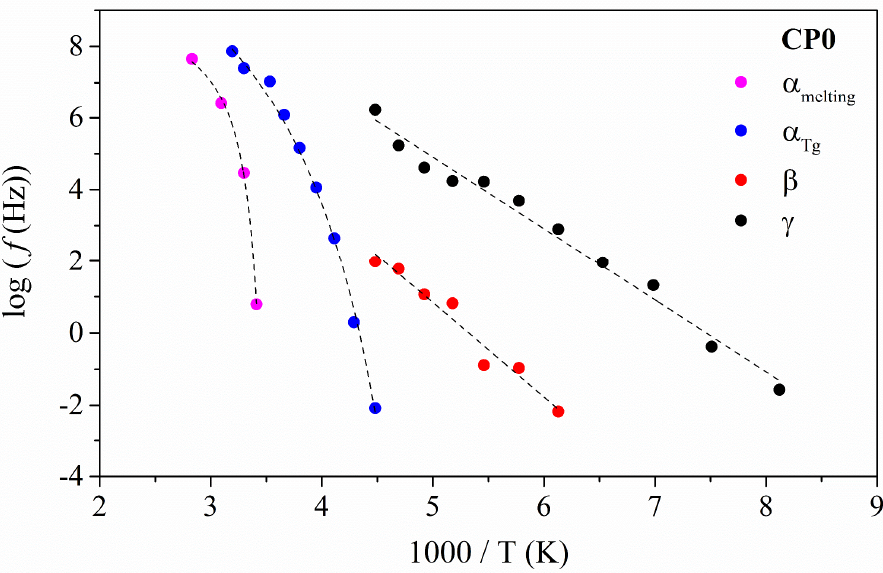
Figure 3. Arrhenius map for the neat copolymer (CP0). Dashed lines represent the line of best fit. The dielectric relaxation attributed to the glass transition of the PECH segments is found between 213 K and 313 K at a frequency of 10 − 1 Hz. This peak is also observed in the dielectric spectra of neat PECH, which may be associated with the glass transition of PECH. It tends to be the prominent relaxation, dominating the entire spectrum in this temperature range [48]. The higher temperature peak is observed between 323 K and 383 K at a frequency of 10 − 1 Hz. This dielectric relaxation is attributed to the molecular motion that promotes the melting. The thermal dependence of the relaxation times ( τ ) with the temperature is plotted in Figure 3 to clarify the molecular origin of each one of these relaxations. The relaxations at low temperatures follow an Arrhenius-like model, thus indicating that their origin is related to non-cooperative molecular motions. The results are gathered in Table 1. Table 1. Apparent activation energy ( E a ) and temperature peak for CP0. Relaxation